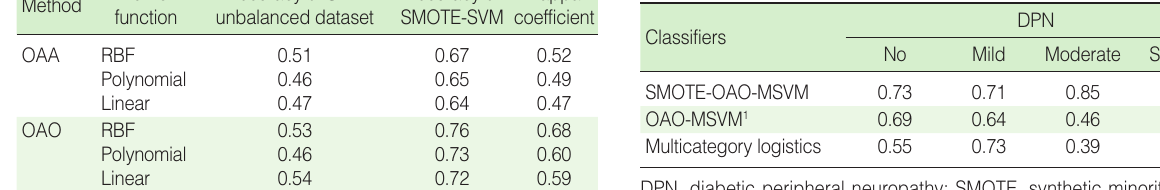
Table 3. The precision of each diabetic neuropathy classification with three